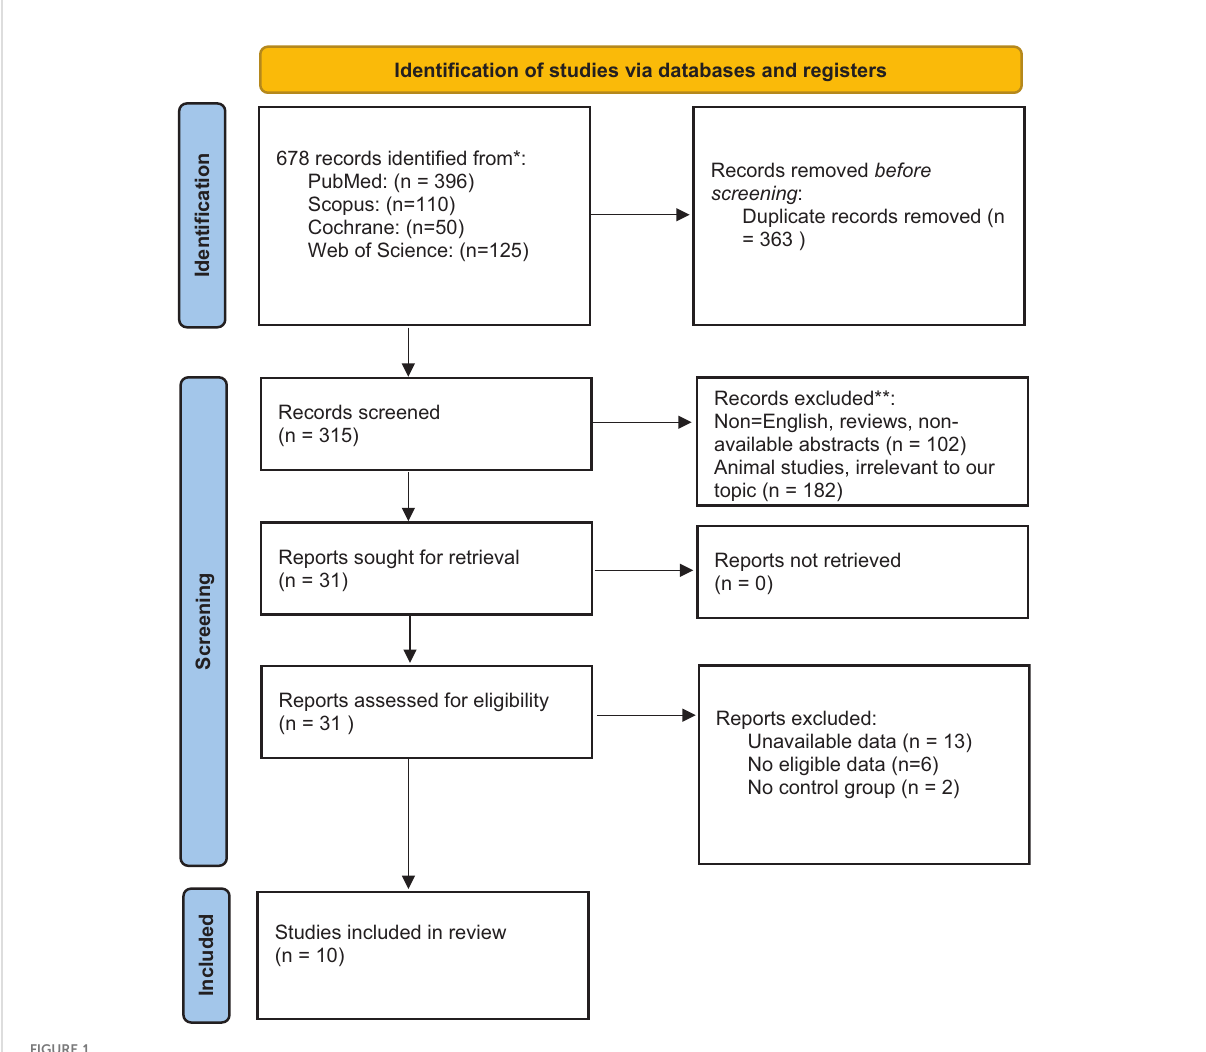
FIGURE 1 PRISMA 2020 fl ow diagram for new systematic reviews which included searches of